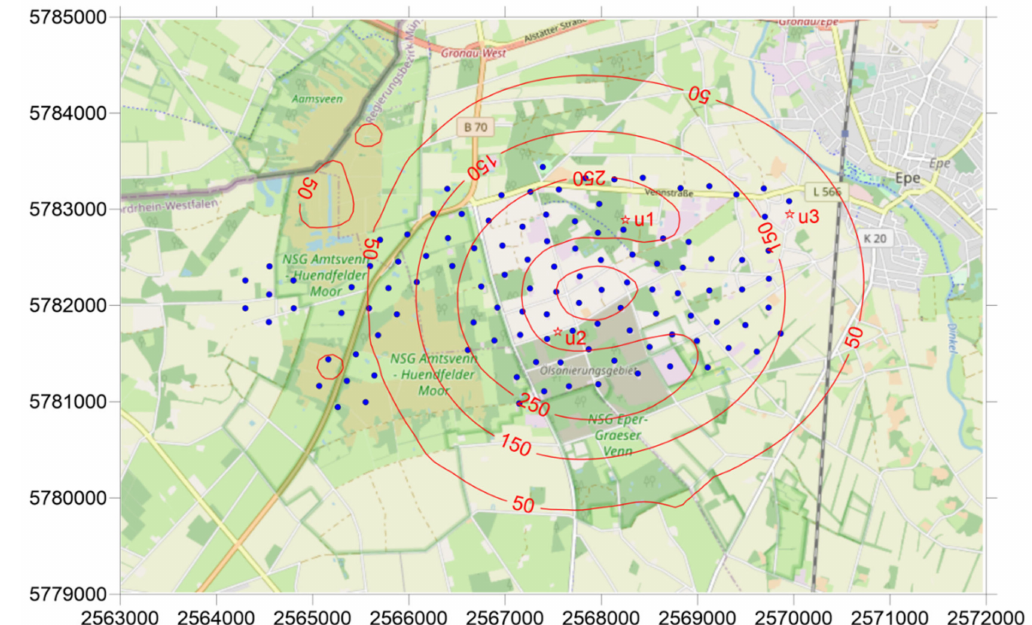
Figure 7. Results of theoretical calculations of horizontal displacement in mm over the EPE cavern field, as per 12.30.2019.